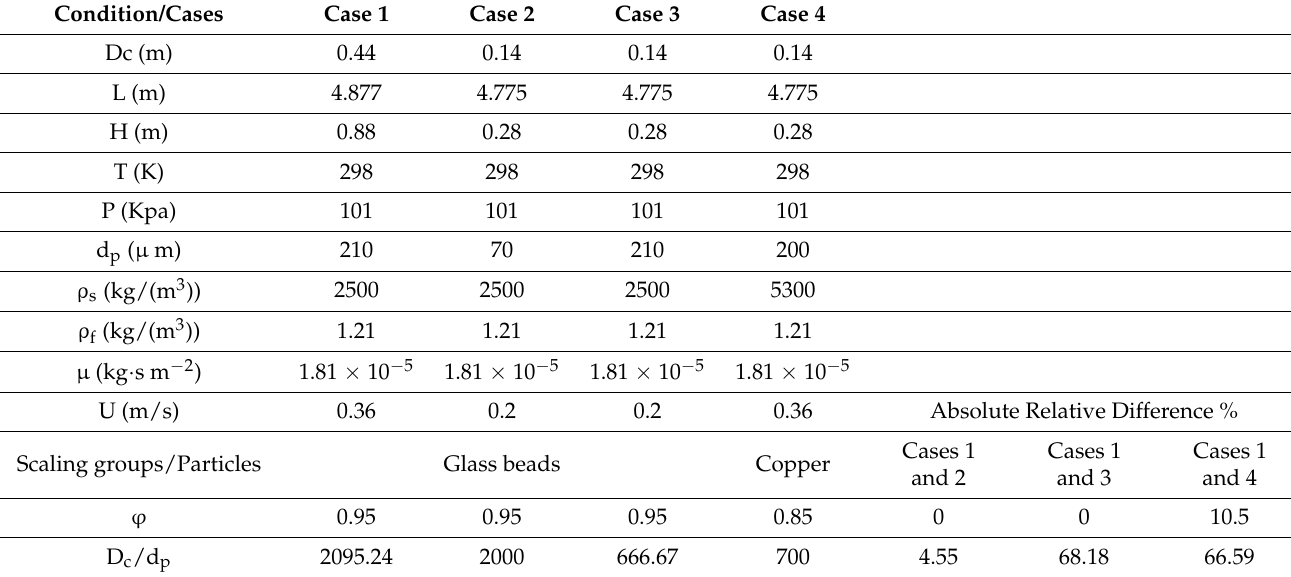
Table 1. The investigated conditions of matched and mismatched dimensionless groups for scale up relationships of fluidized